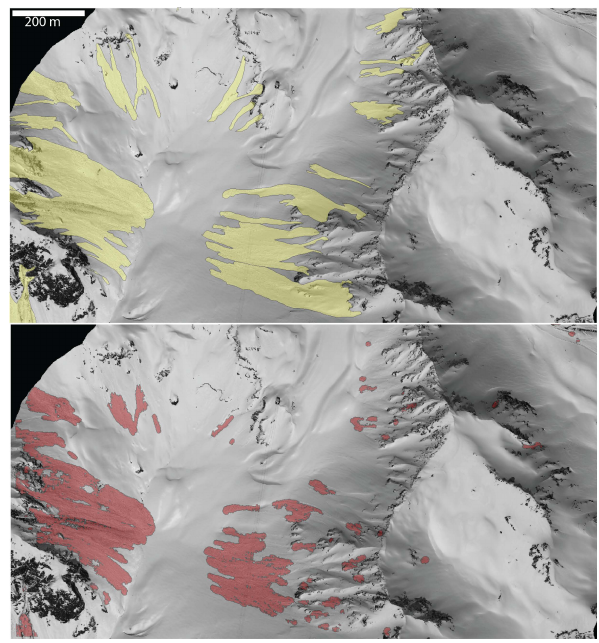
Fig. 8. Leica panchromatic imagery collected near the Davos- Parsenn ski resort. Image (a) (above) illustrates manual mapping of snow avalanches in ArcGIS, while image (b) (below) is processed automatically in eCognition and then visualised in